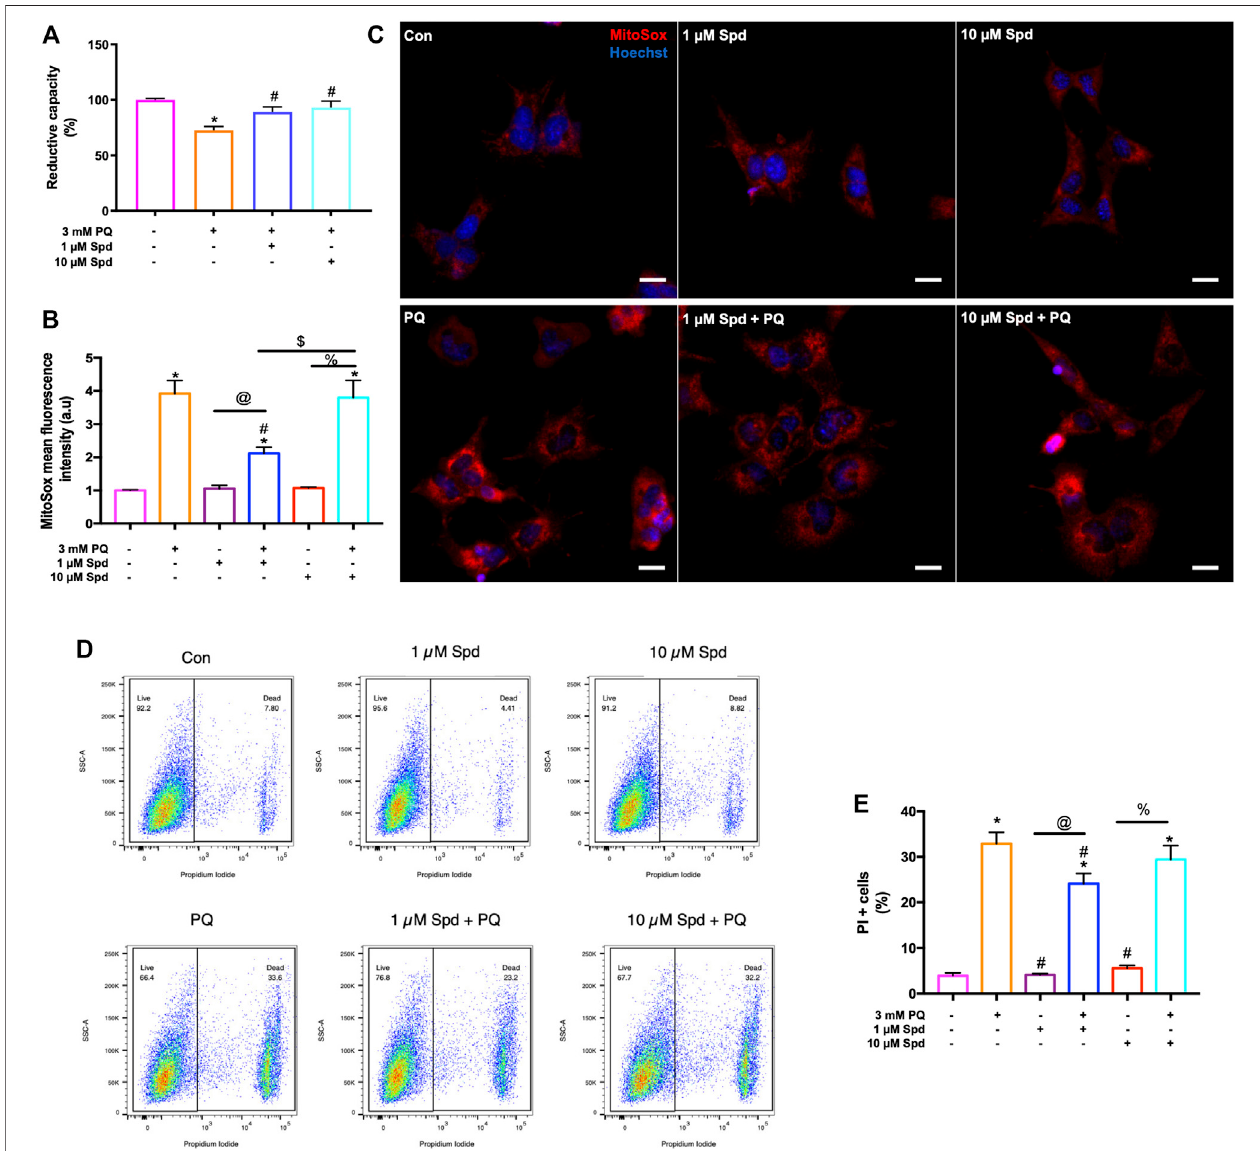
FIGURE7| LowconcentrationofspermidinereducesROSproductionanddelaycelldeathonsetfollowingparaquat-inducedneurotoxicity. (A) Reductivecapacity indicating an improvement in cellular viability in cells pre-treated with spermidine compared to PQ alone. Data are presented as mean ± SEM, n = 3 with 6 replicates per group. * = p < 0.05 vs control, # = p < 0.05 vs PQ. (B) quantitative analysis of mitochondrial ROS production and (C) representative fl uorescence micrographs following treatments.MitoSox fl uorescenceintensitywasincreasedinPQtreatedgroup,whiledecreasedwith1 μ MSpd+PQ.Scalebar:20 μ m. (D,E) quantitativeanalysis ofcelldeathonsetfollowingtreatments.PIpositivecellswerereducedin1 μ MSpd+PQcompared toPQtreatedgroup.Dataarepresented asmean±SEM, n =3with 2 replicates per group. * = p < 0.05 vs control group, # = p < 0.05 vs. PQ, @ = p < 0.05 vs. 1 μ M Spd, % = p < 0.05 vs. 10 μ M Spd, and $ = p < 0.05 vs 1 μ MSpd +